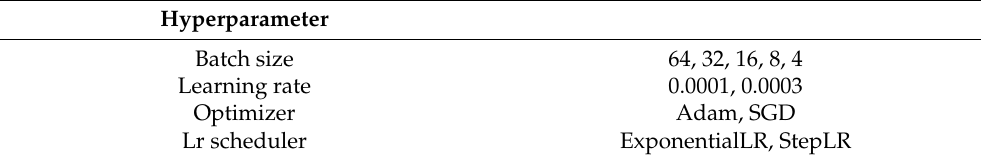
Table 2. Hyperparameters adjusted in the